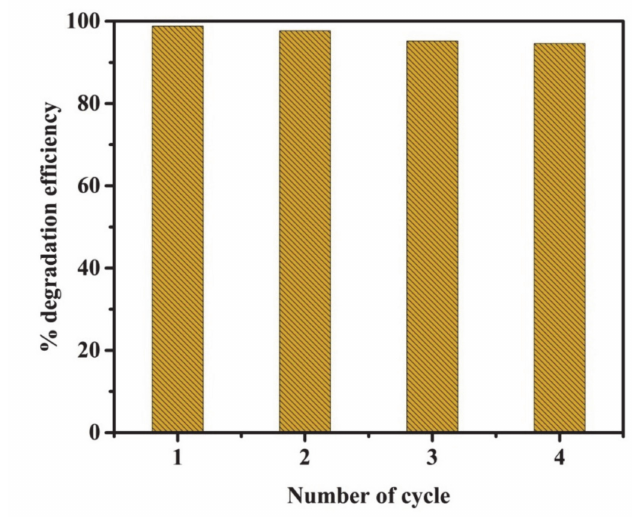
Figure 10. Photocatalytic recyclability test of 50 wt.% g-C 3 N 4 supported on SrAl 2 O 4 :Eu,Dy-0.01M SiO 2 .